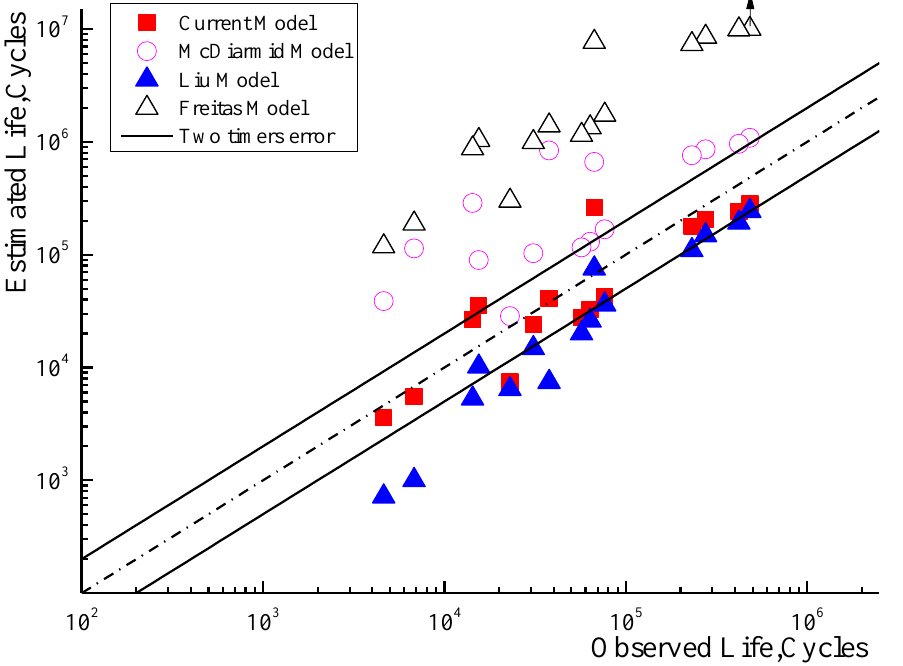
Figure 7. Experimental and predicted results for aluminum alloy LY12CZ.